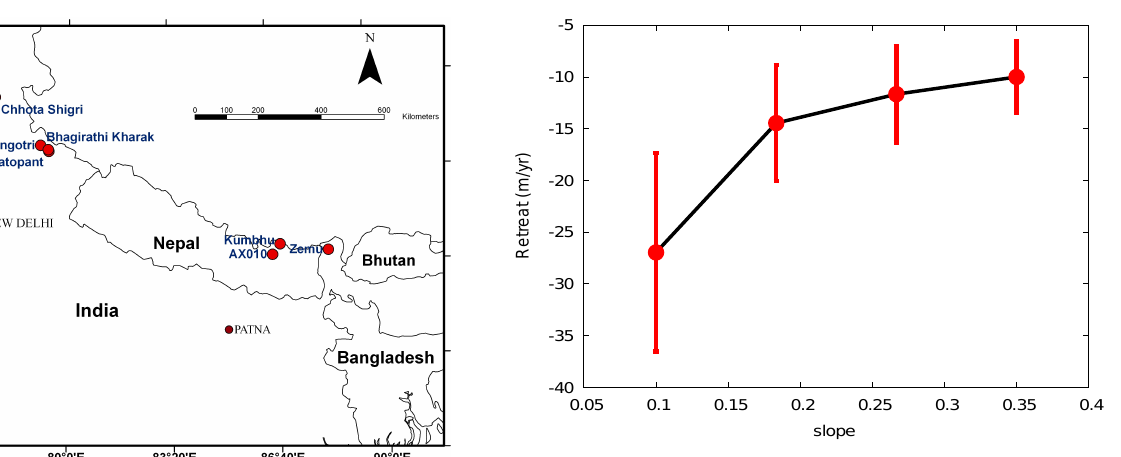
Fig. 3. Observed variation of retreat rates with slope, for glaciers in the Parbati and Baspa basins. The solid circle represents the mean value and bars, the standard deviation. The set consists of 57